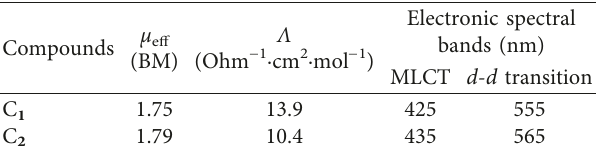
Table 1: Electronic spectra and magnetic moments of the metal